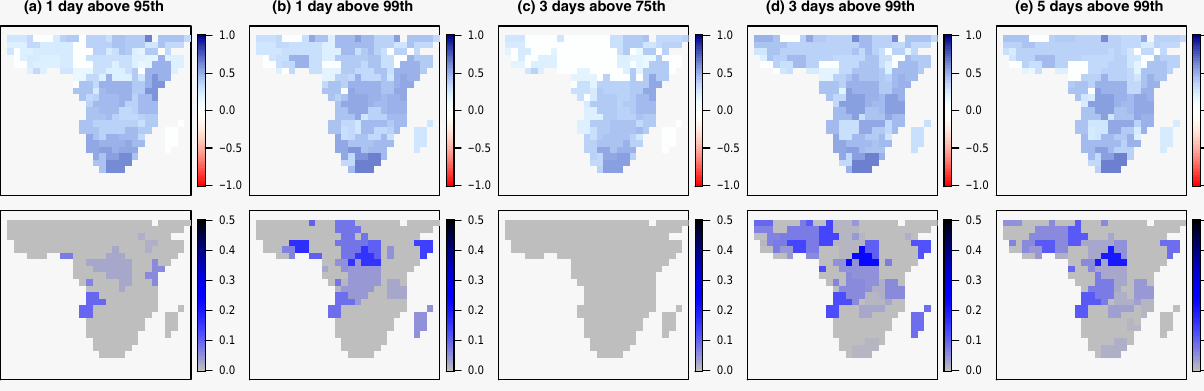
Figure 2. Correlation of the number of extreme events within a season and floodiness for FPUs in Africa. The top row shows the anomaly rank correlations between each variable and percentage floodiness at the 5-year return period at the FPU level. The bottom row is the improvement relative to seasonal total rainfall – locations in blue show a higher anomaly correlation for this variable than for seasonal total rainfall anomalies. Areas in which seasonal total rainfall has a higher or equal correlation are shown in grey. Note that results are only plotted for locations where more than 95% of the boostrapped replicas agree on the sign of the change.